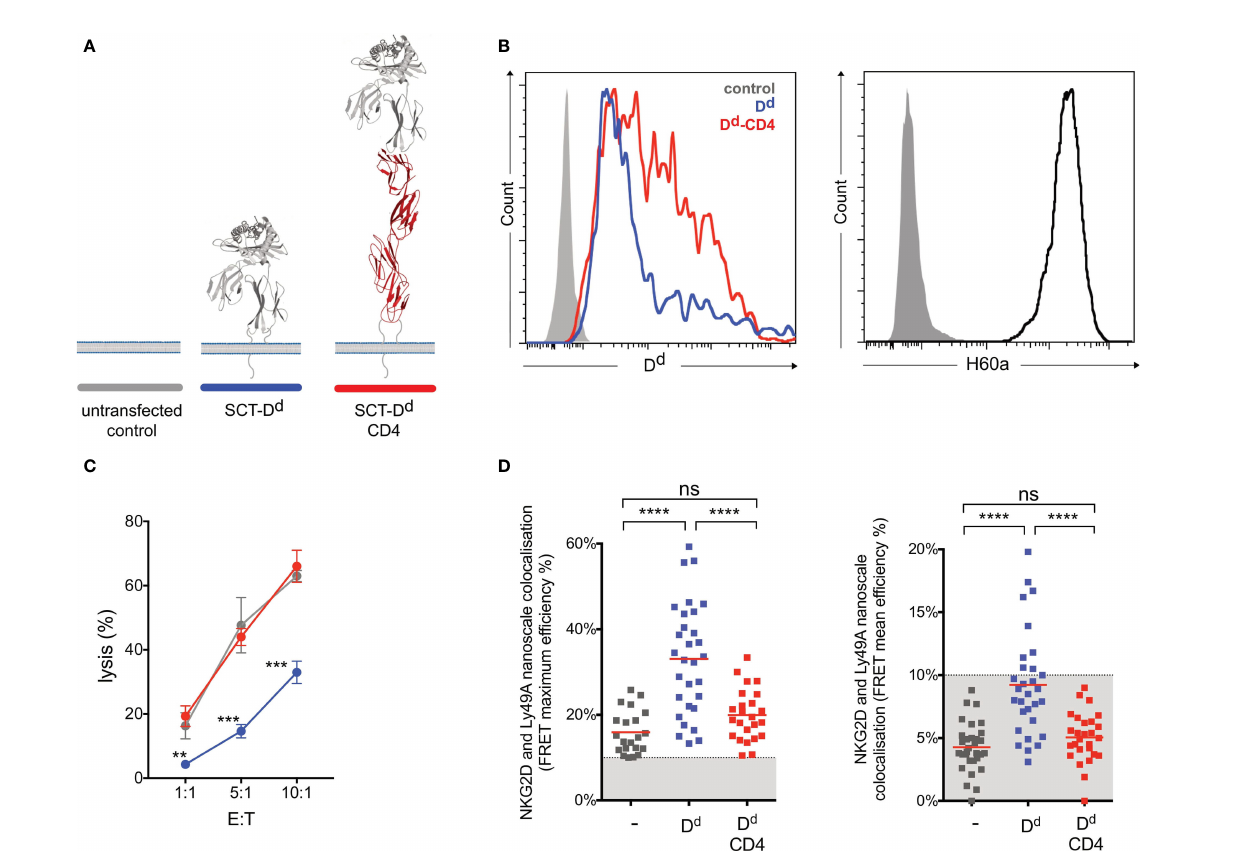
FIGURE 5 | Ly49A-mediated inhibition of NKG2D-mediated natural killer (NK) cell activation correlates with the colocalization of Ly49A with NKG2D at the nanometer scale. (A) Schematic representation of SCT Dd Ly49A ligand and its elongated form. (B) H-2-Dd cell surface staining (antibody clone 34-2-12) of NIH3T3 transfectants (left panel). The control (solid gray) corresponds to untransfected NIH3T3 cells, while Dd (blue) and Dd-CD4 (red) correspond to NIH3T3 cells with similar levels of ligand expression. NIH3T3 cells endogenously express H60a (right panel). (C) Elongation of Dd reduces Ly49A-mediated NK cell inhibition. Untransfected NIH3T3 (control, grey), NIH3T3 SCT Dd (Dd, blue), and NIH3T3 SCT Dd-CD4 (Dd-CD4, red) transfected cells expressing similar levels of ligands were used as target cells. IL-2-expanded NK cells from C57BL/6 mice were used in a killing assay at the indicated effector/target ( E : T ) ratios. Data show the mean ± SD %lysis ( n = 3), and groups with a statistically signi fi cant difference are shown as follows: ** p < 0.01, *** p < 0.001, **** p < 0.0001; ns, no statistically signi fi cant difference ( p > 0.05). Two-way analysis of variance (ANOVA) with p = 0.0015 and multiple unpaired t -tests were used by applying the Holm – Sidak method. Data are representative of two independent experiments. (D) Colocalization of NKG2D and Ly49A at the nanometer scale correlates with NK cell signal integration. Similarly, lower average and maximum FRET values were observed for NK immune synapses obtained using untransfected NIH3T3 or NIH3T3 SCT Dd-CD4 transfected cells. Higher levels of NKG2D and Ly49A colocalization were observed using NIH3T3 SCT Dd transfected cells. FRET ef fi ciency was calculated pixel by pixel, and the mean and maximum values registered for each NK immune synapse (IS) are shown in the right and left panels, respectively. Each square point represents a unique NK synapse. All NK ISs were acquired using NK cells expressing both NKG2D-GFP and Ly49A-RFP. The results are from three independent experiments using primary NK cells harvested from 3 different retrogenic mice. A minimum threshold of 10% FRET ef fi ciency was applied. The graphs show the mean percentage ± SEM from at least 26 synapses. Ordinary one-way ANOVA and Tukey ’ s multiple-comparisons test were used, and groups with a statistically signi fi cant difference are shown as follows: ** p < 0.01, *** p < 0.001, **** p < 0.0001; ns, no statistical signi fi cance ( p >